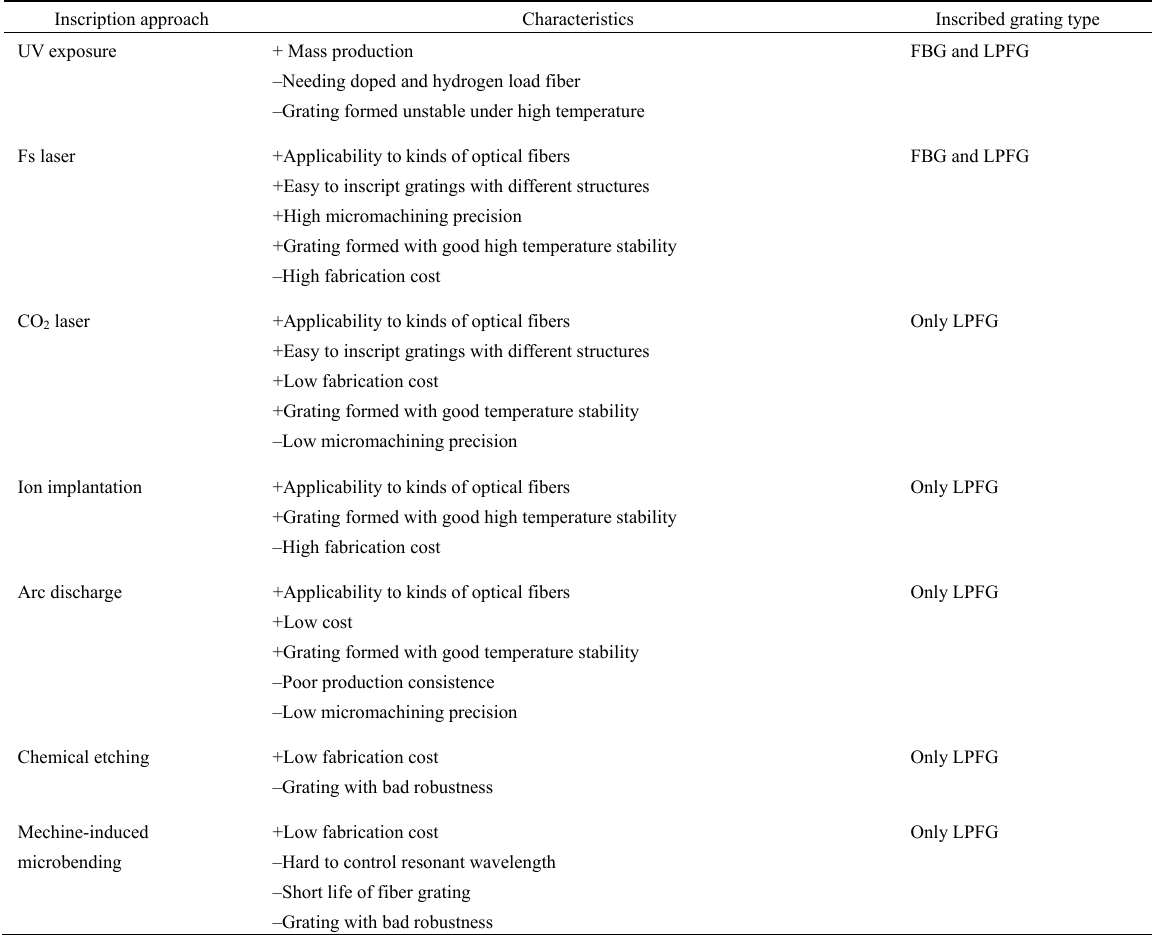
Table 1 Summary of the normal inscription approaches of the fiber grating.